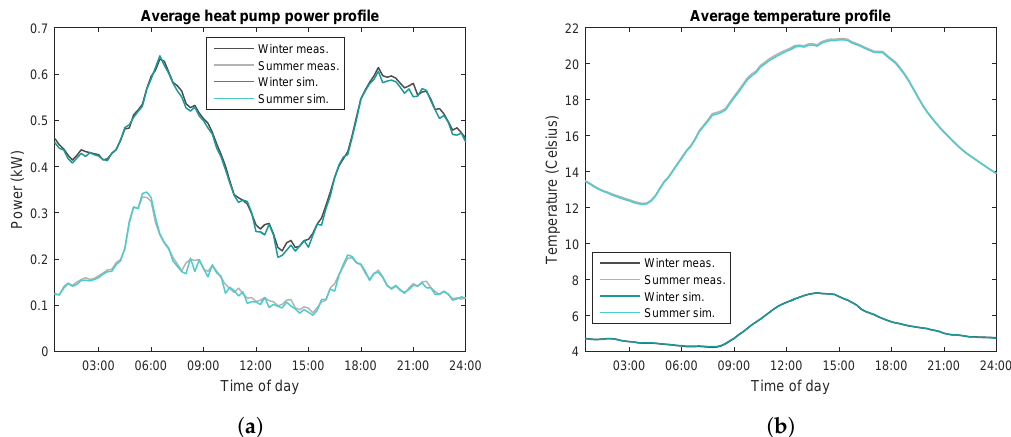
Figure 13. ( a ) Average heat pump load profile during winter and summer. ( b ) corresponding average temperature profiles.